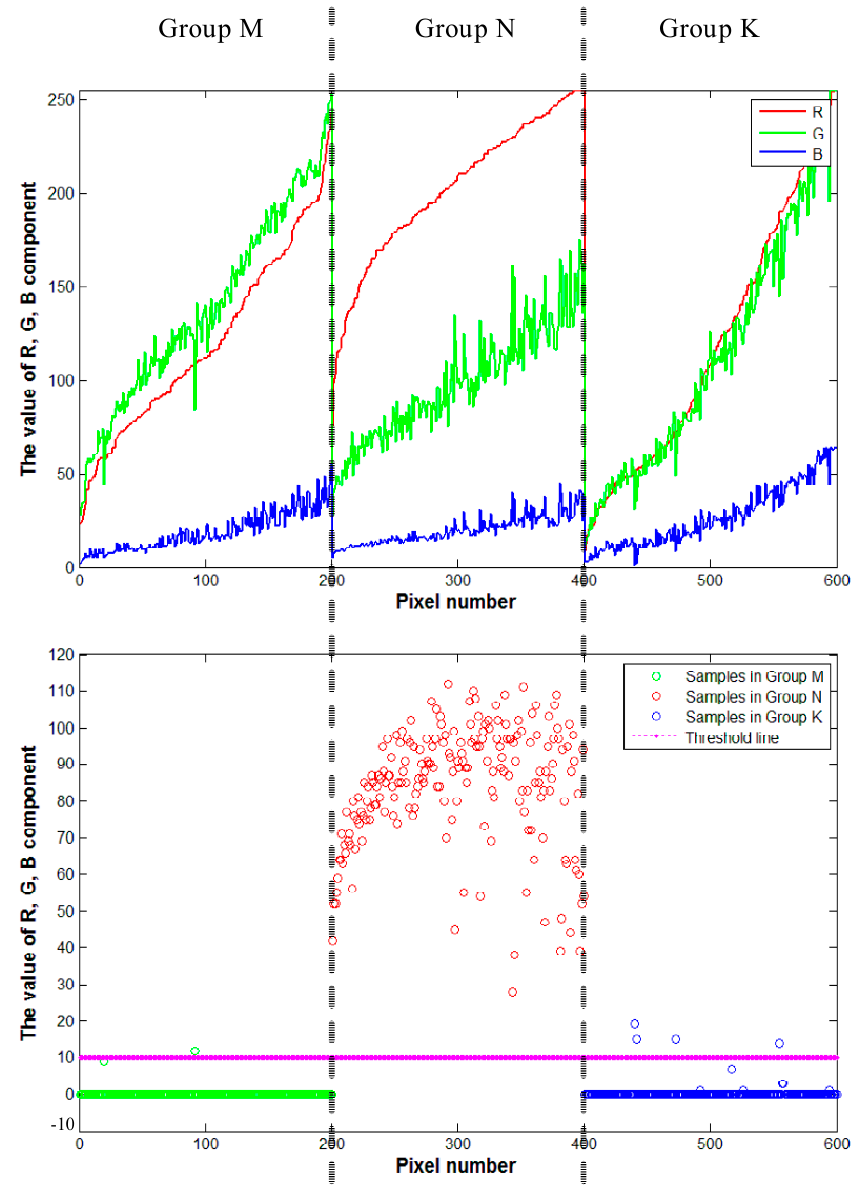
Figure 5. The results of Equation (1) for sample points.